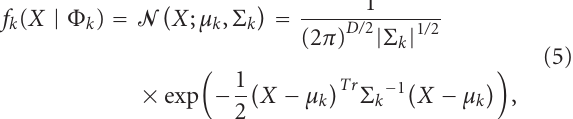
Figure 2: Preprocessing